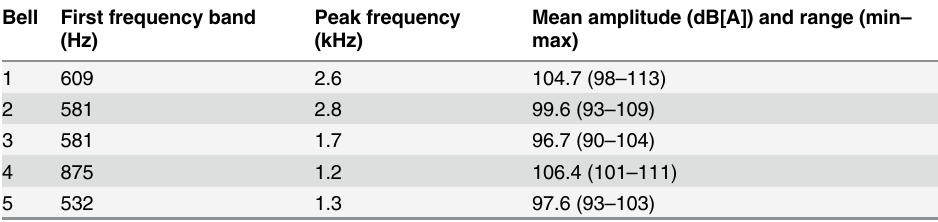
Table 2. Frequency characteristics and amplitudes of the bells used in the experiment recorded at a distance of approx. 20 cm while manually moving the bells in a standardized way for 1 min each. Bell First frequency band Peak frequency (Hz)